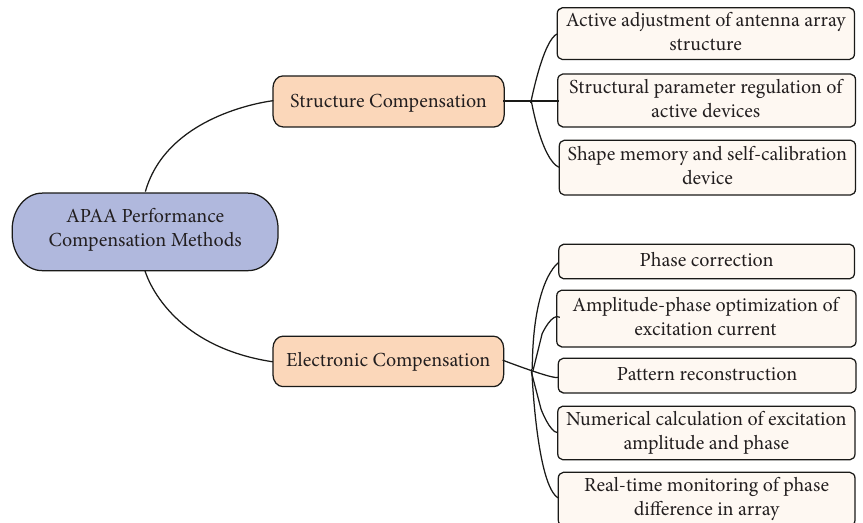
Figure 15: Compensation method of